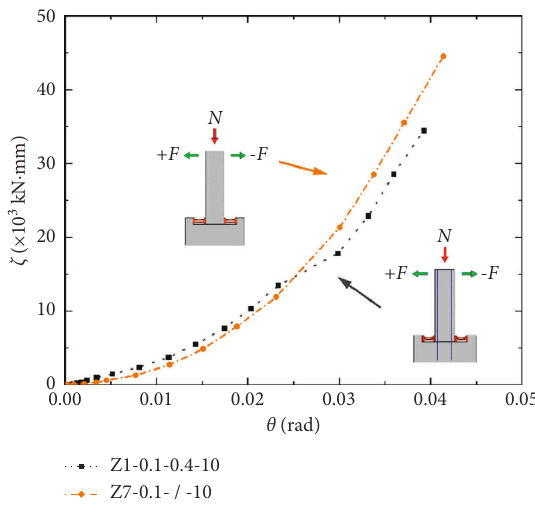
Figure 19: Comparison of equivalent viscous damping coefficient h c curves of RED-HRC and RED-ORC.